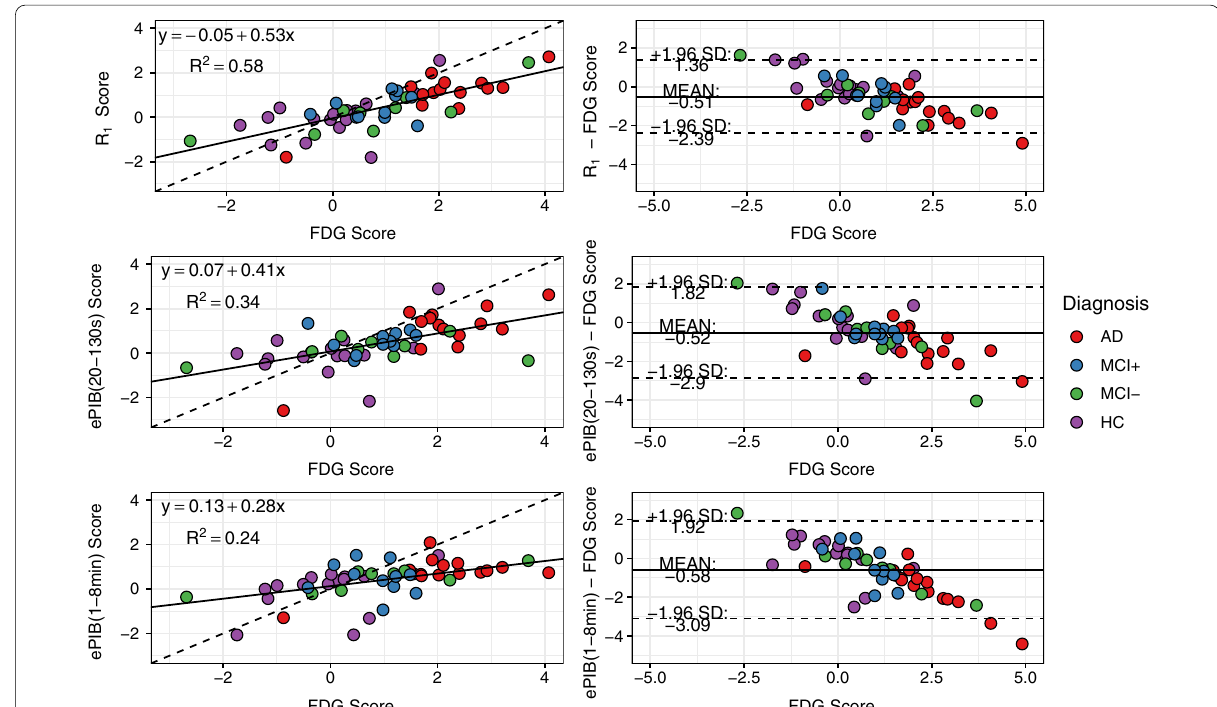
Fig. 5 Scatter and Bland–Altman Plots . Scatter plots (left column) of scores from R 1 parametric images (top), ePIB(20–130 s) (middle), and ePIB(1–8 min) (bottom) images ( y -axis), compared to FDG ( x -axis). The dashed line represents the identity. Results from the linear regression applied to the data are shown in the upper left corner of the plots and as a solid line. Bland–Altman plots (right column) show the difference between the scores provided by R 1 (top), ePIB(20–130 s) (middle), and ePIB(1–8 min) (bottom) and FDG. The solid line is at the average difference between the scores, and the dashed lines delimit the limits of agreement of the 95% interval (at mean according to group: in red, the AD patients; in blue, the MCI